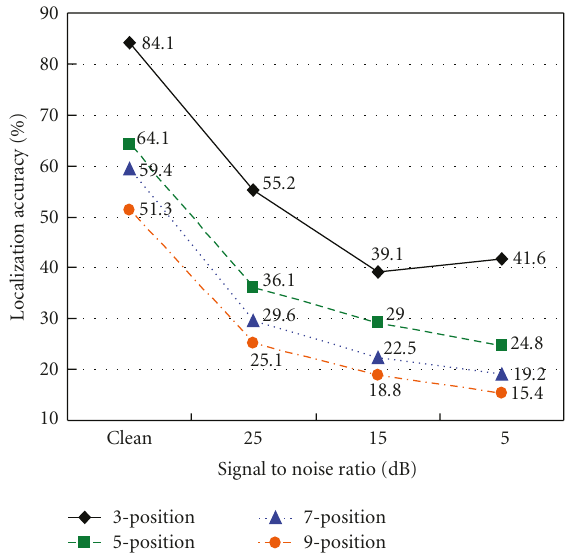
Figure 9: Localization accuracy for noisy environments.